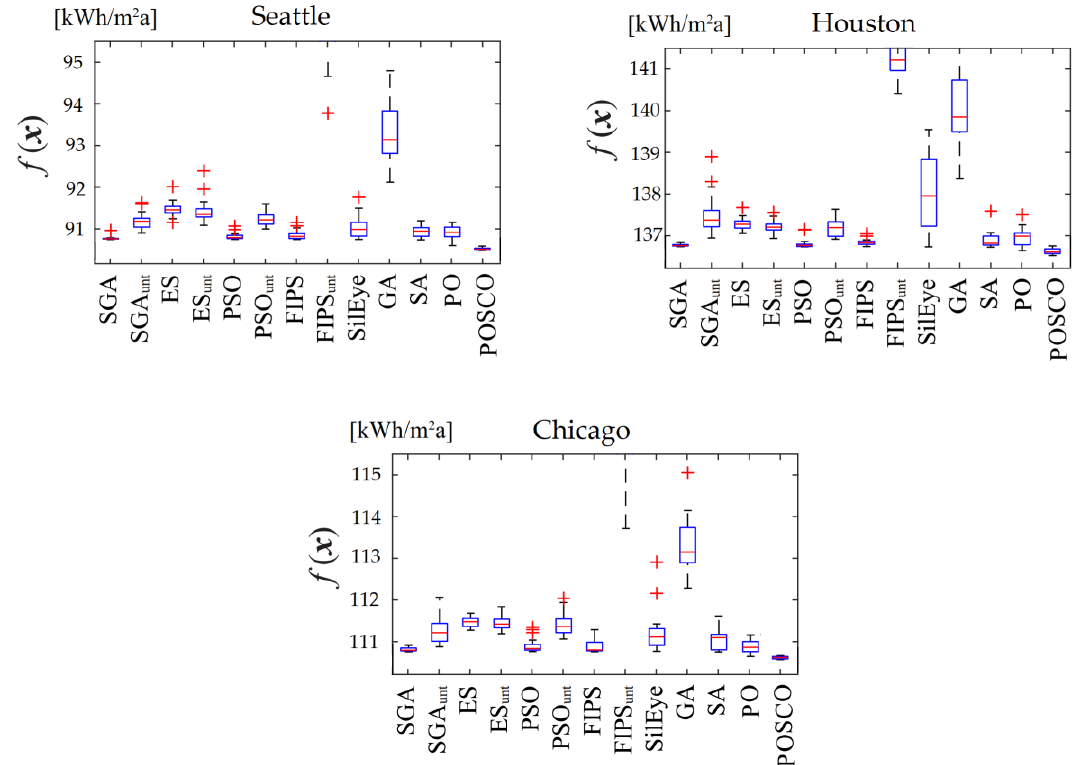
Figure 7. Box-Whisker plots of the results comparison for the detailed